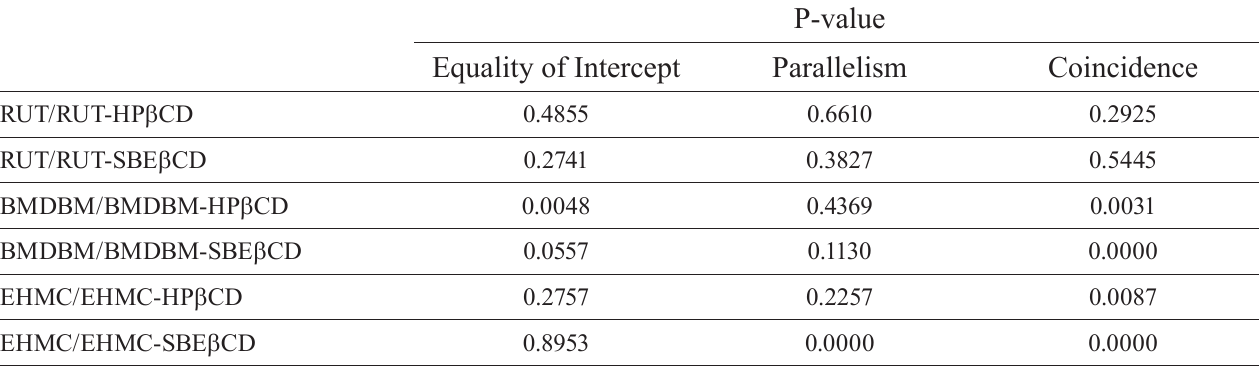
TABLE III - P-values for the tests of equality of intercept, parallelism, and coincidences of the lines ( α =